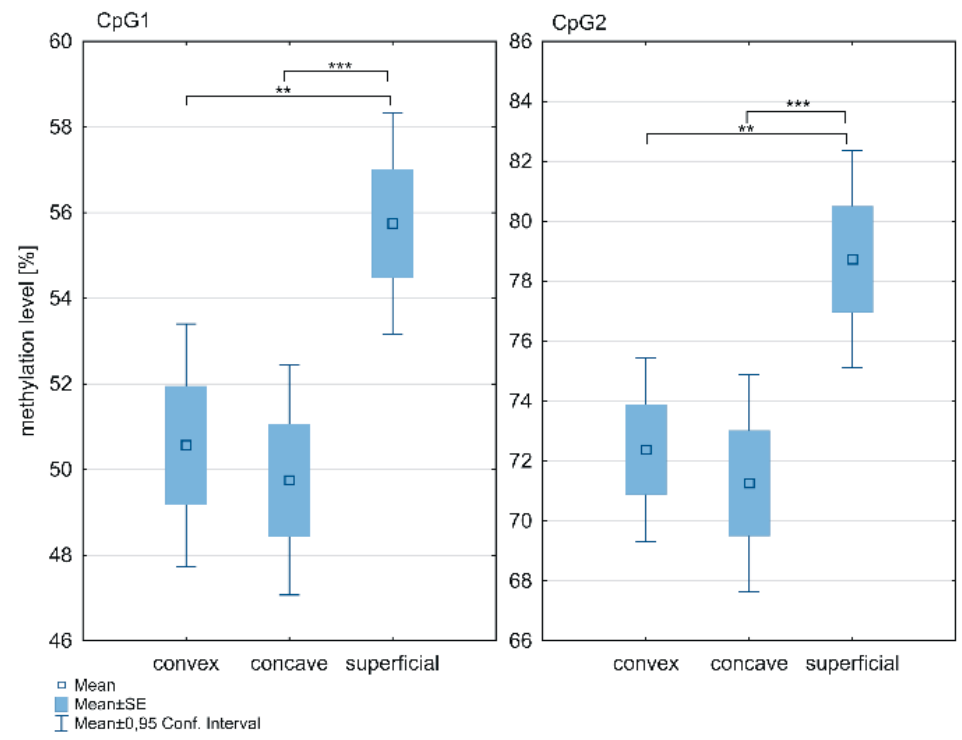
Figure 3. DNA methylation level within ESR1 T-DMR1 region in deep paravertebral muscles and superficial muscles; ** p < 0.01, *** p < 0.001.